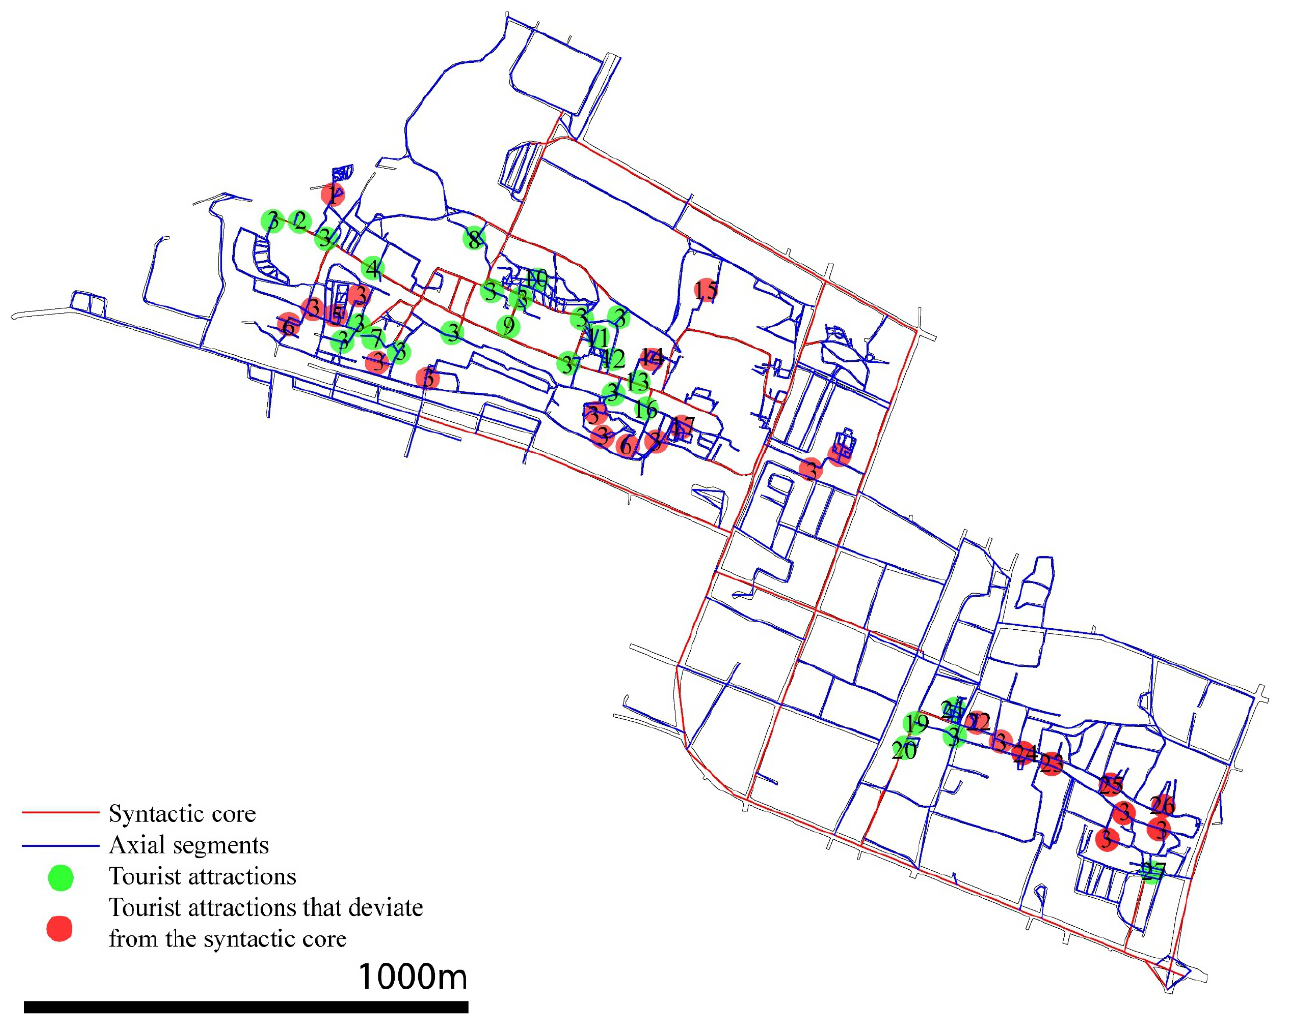
Figure A4. The POI tourist attraction distribution in Wuzhen. The red colour indicates that tourist attractions deviate from the syntactic core of the town.